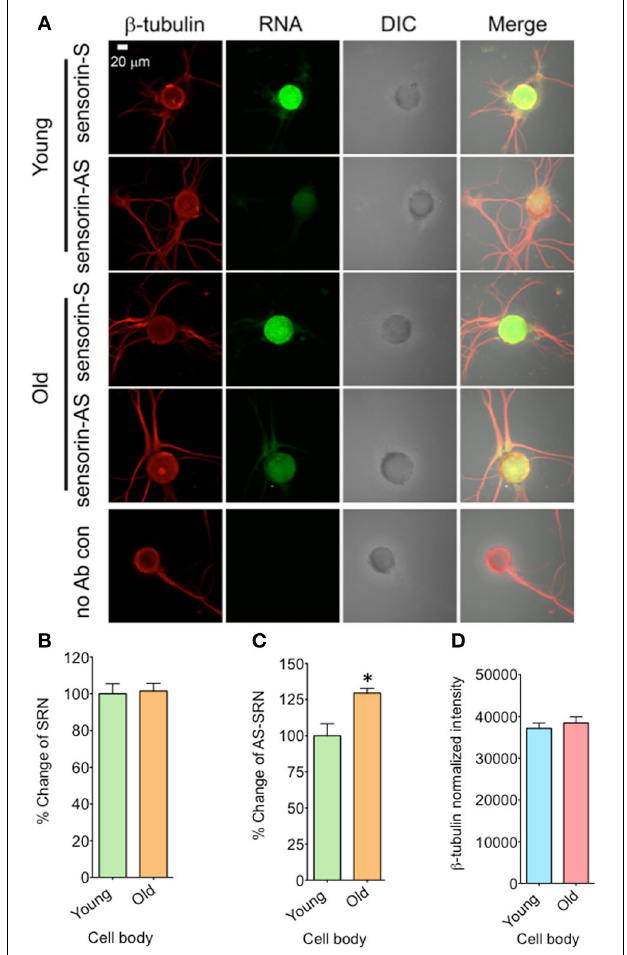
FIGURE 2 | Aging associated changes in expression of NAT-SRN in the cell body of Aplysia sensory neurons. (A) Confocal projection images of sensorin RNA (Green) co-stained with β -tubulin protein (Red), DIC and merged images are shown. A no antibody (Ab) control was used as non-specific hybridization control. Scale bar, 20 μ m; (B,C) are the percentage changes of SRN and NAT-SRN distribution in the cell body of DIV4-cultured sensory neurons from young (3 months old) and old (9 months old) groups of Aplysia using fluorescently labeled sense and antisense ribo probes, respectively. RNA in situ hybridization analysis of (D) is the normalized intensity of β -tubulin protein distribution in young and old neurites. Normalized mean fluorescence intensities measured using NIH ImageJ are shown in bar graphs. Error bars are SEM. Student’s t -test was used to determine statistical significance. “ ∗ ” is p < 0 .